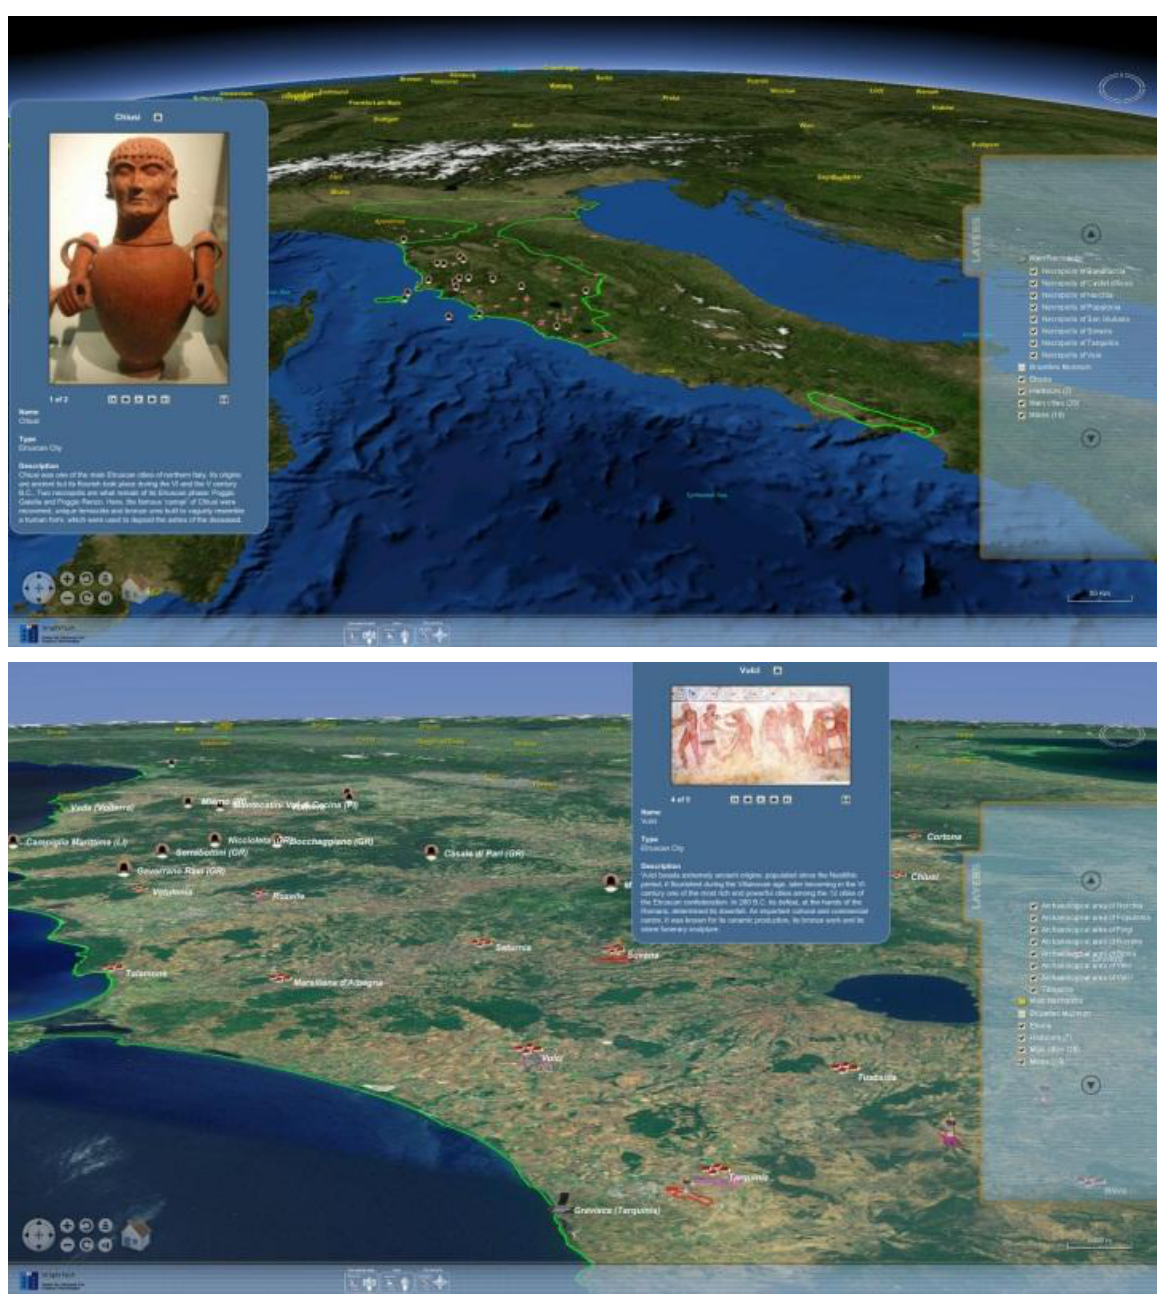
Figure 13. A geo-browser tool for landscape visualization and data queries